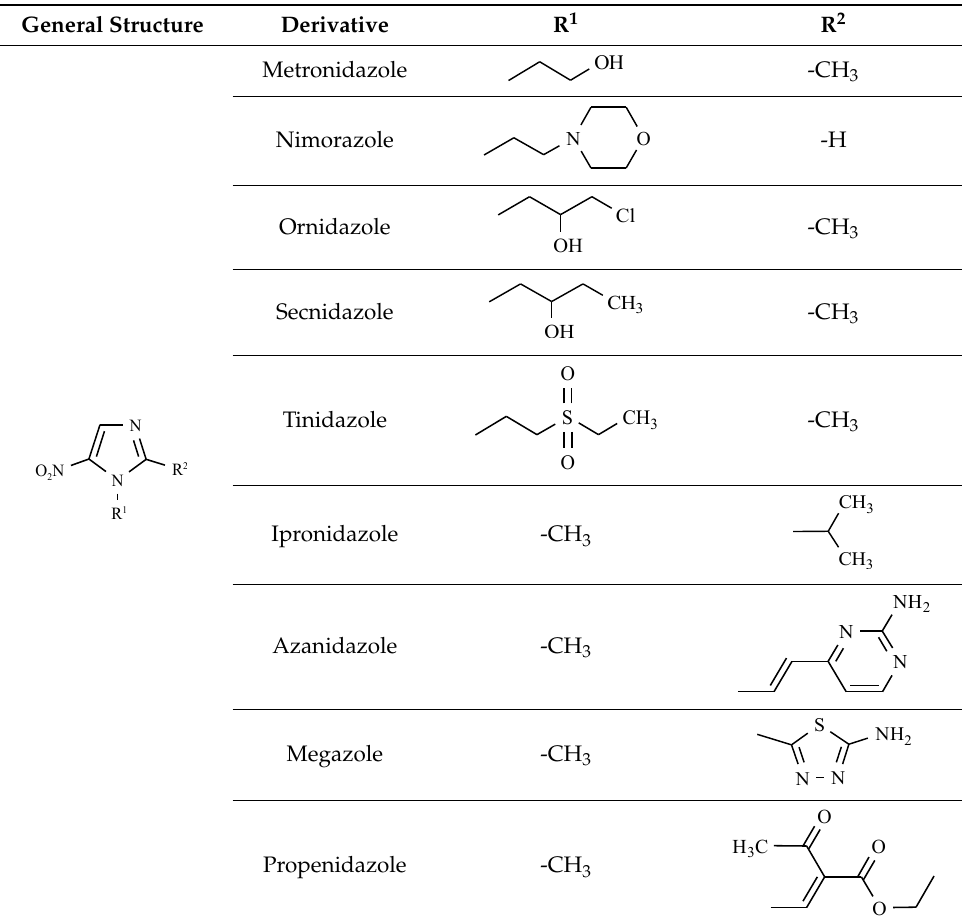
Table 4. Antibacterial 5-nitroimidazole derivatives.